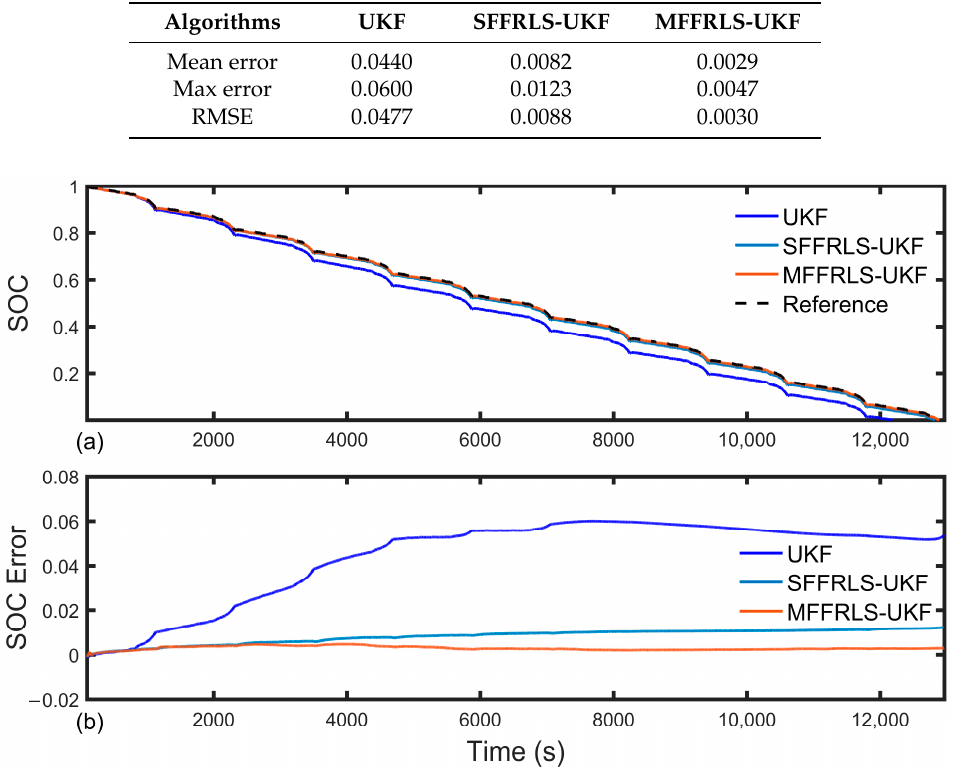
Table 8. Statistic characters of SOC estimation of NEDC test under variable temperature.